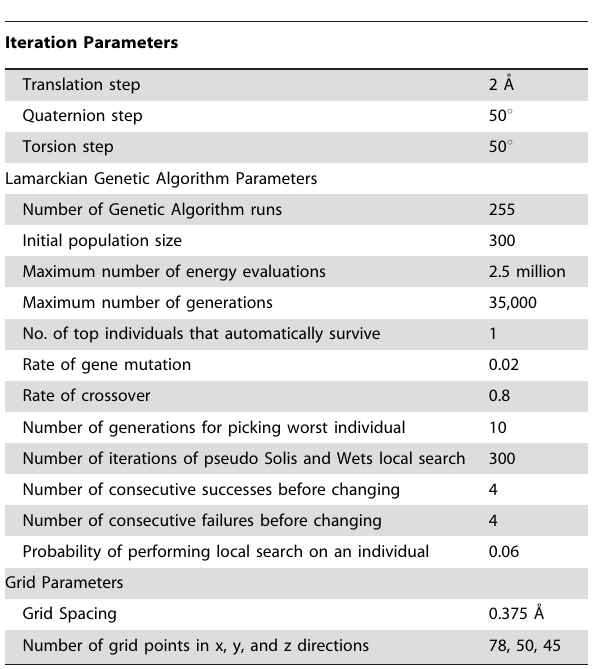
Table 1. Parameters used for docking simulation.